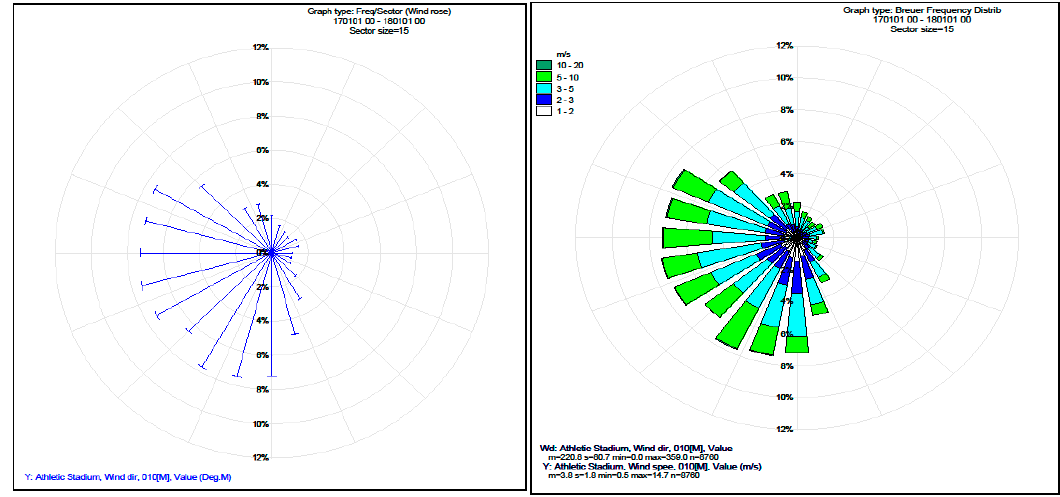
Figure 4. Breuer frequency distribution (wind rose) for year 2017 weather data used in the Airviro model.